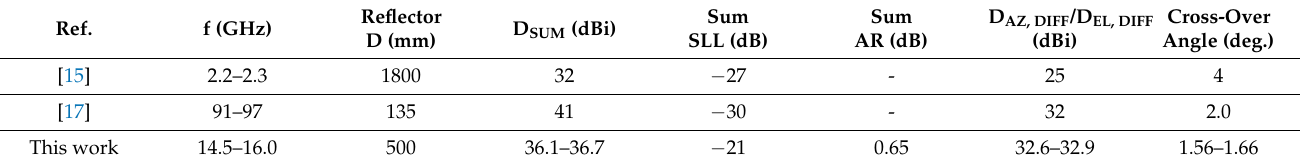
Table 5. Comparative analysis.